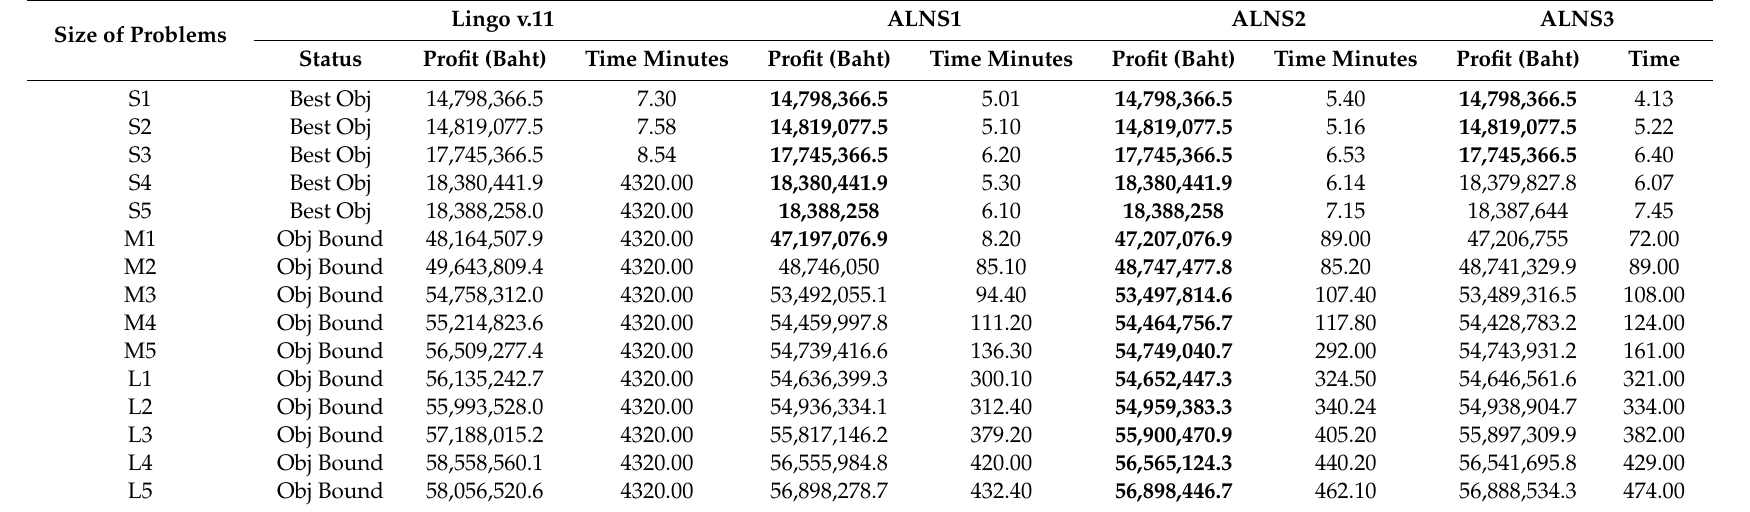
Table 3. Lingo sample test results with the Adaptive Large Neighborhood Search (ALNS) method as compared to the Lingo program. Size of